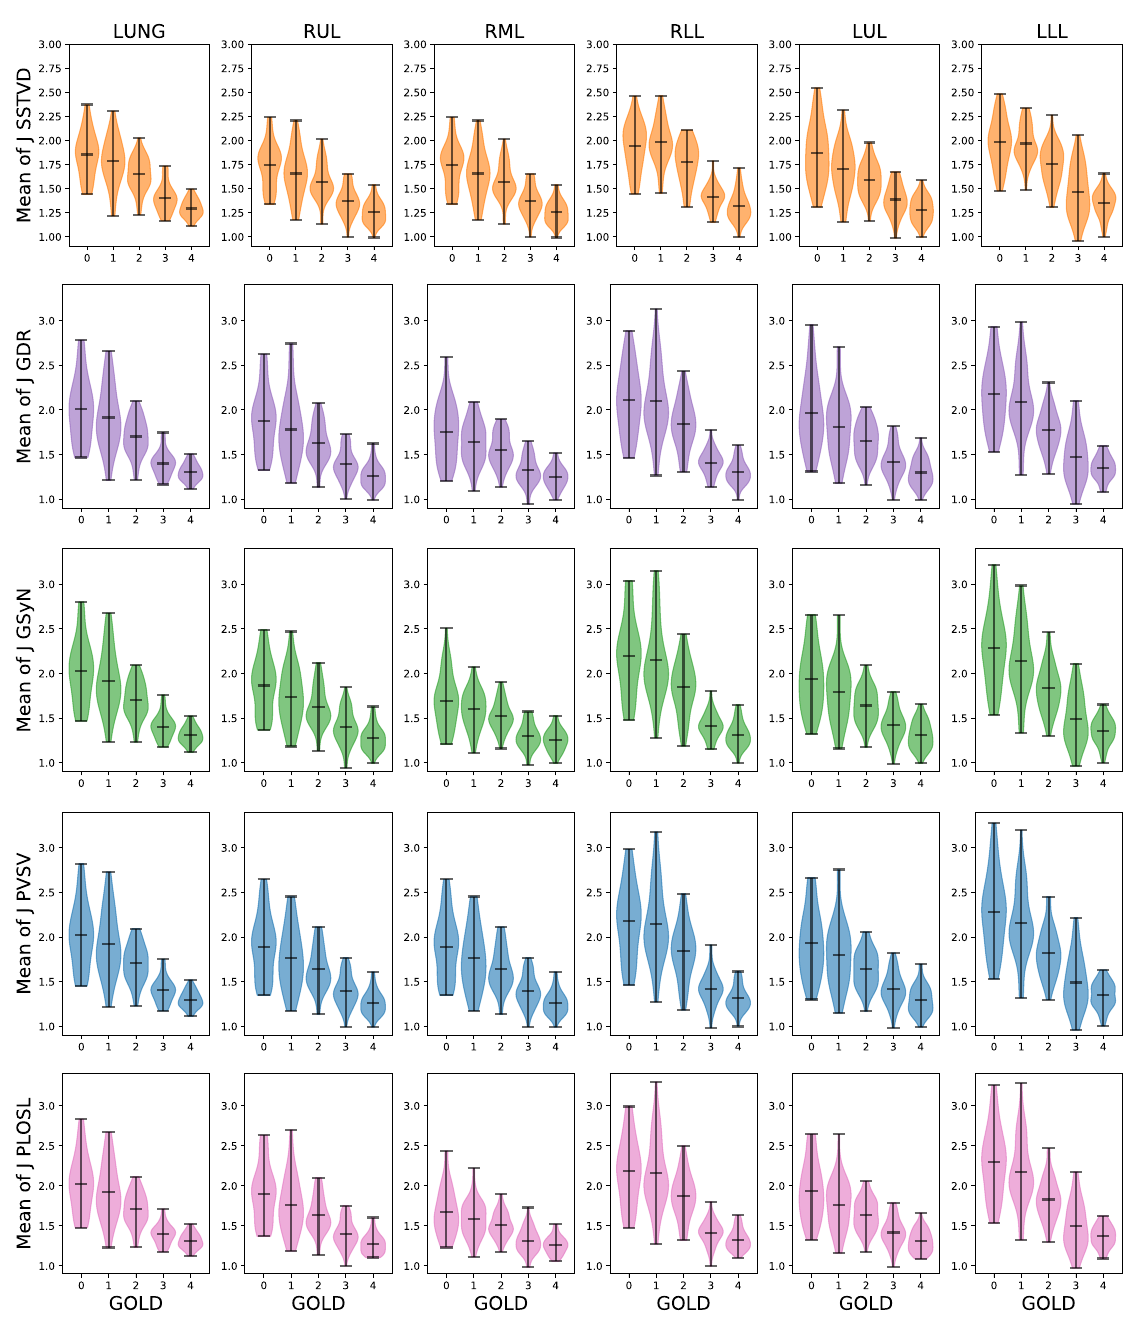
Figure 6. The robustness of average J with respect to different registration algorithms gloablly and on a lobe-by-lobe basis. For each row, the first column is the averaged J of lung region (LUNG). The five remaining columns correspond to the averaged results within five lobes of the lung, respectively. RUL, RML, and RLL refer to right upper, middle and lower lobe, respectively, whereas LUL and LLL represent left upper and lower lobe. Each row corresponds to the five registration algorithms: SSTVD, GDR, GSyN, PVSV and PLOSL,